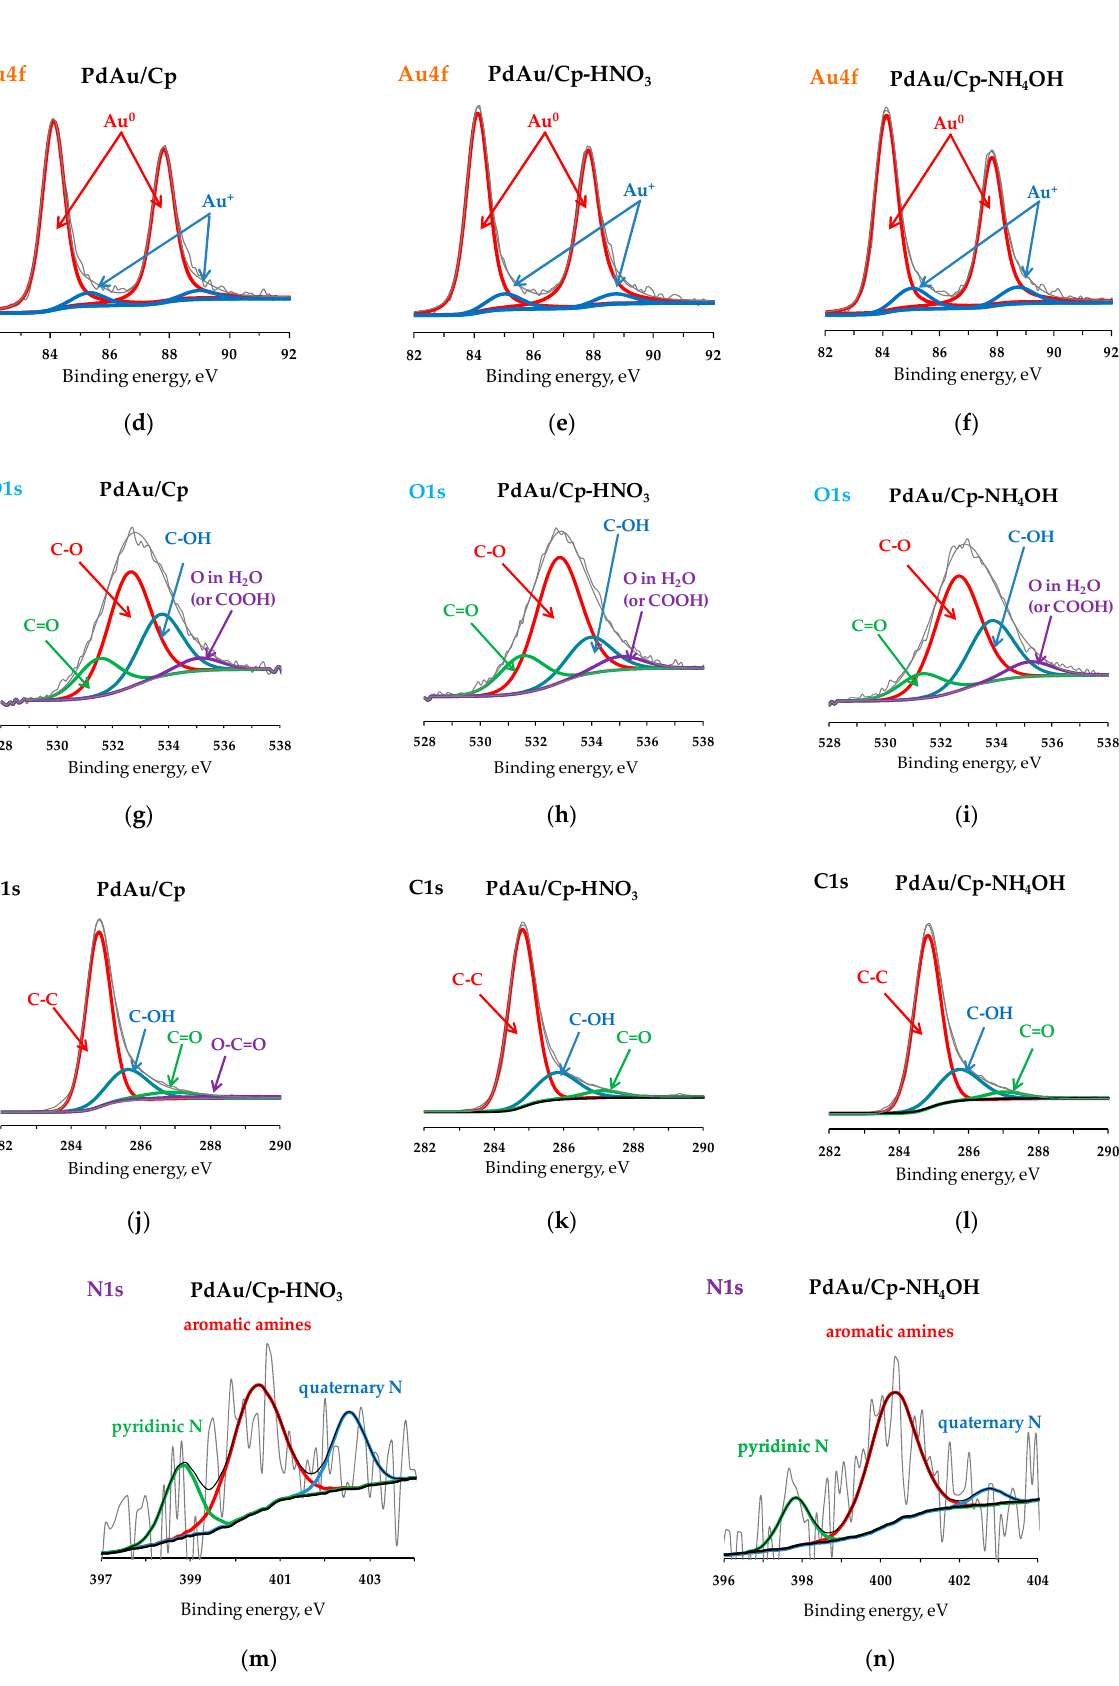
Figure 5. XPS spectra of Pd3d ( a – c ), Au4f ( d – f ), O1s ( g – i ), C1s ( j – l ), N1s ( m , n ) peaks for catalysts PdAu/Cp ( a , d , i , j ), PdAu/Cp-HNO 3 ( b , e , h , k , m ) and PdAu/Cp-NH 4 OH ( c , f , i , l , n ), and assignments of their deconvoluted